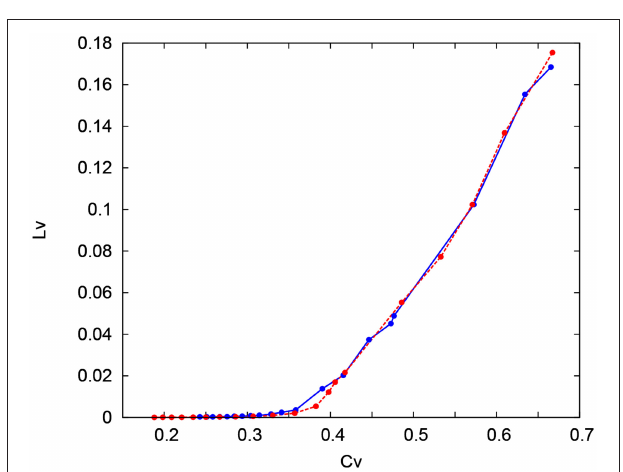
FIGURE 14 | C V − L V characteristics in the IB classes. The C V − L V characteristics of the Pospischil (red) and DSSN (blue)